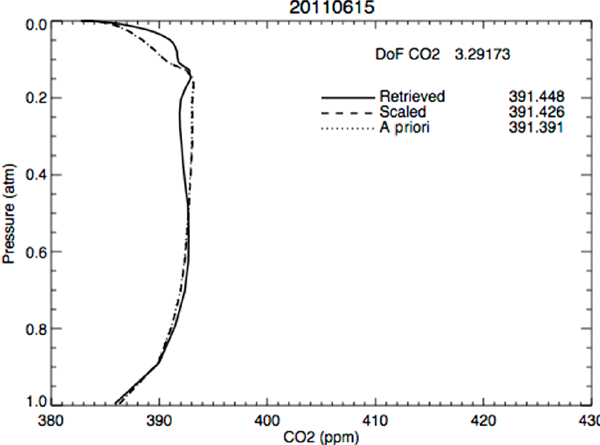
Figure 7. Retrievals of the spectra used for Fig. 6 but with an as- sumed error of 7% in the instrument field-of-view.